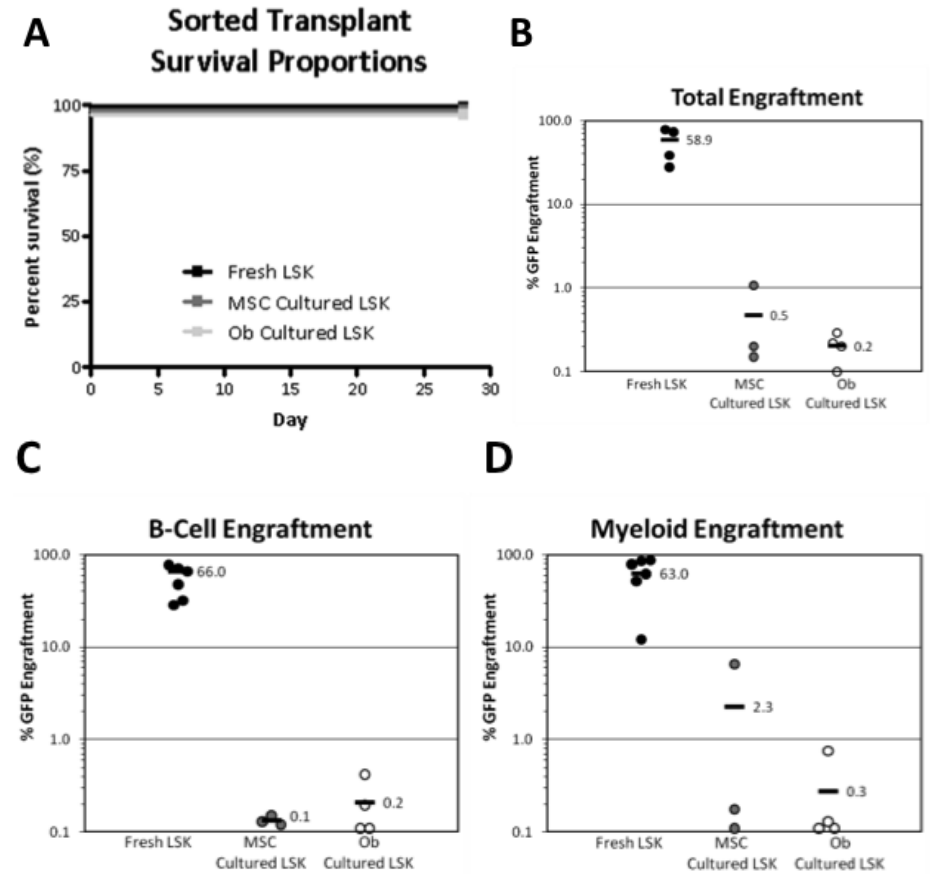
Figure 5. Primary transplantation of co-culture LSKs after removal of stromal cells. Co-cultures were initiated with GFP + LSKs and unlabelled MSCs or osteoblasts. After harvest of cultures, flow cytometry sorting was performed and only cells expressing GFP, containing cultured haematopoietic cells but devoid of undifferentiated MSCs or osteoblasts, were selected. These were then transplanted into myeloablated primary recipients. ( A ) Four week survival was 100% in each group. However, the proportion of GFP + LSKs contributing to total haematopoietic cells in the ( B ) blood, ( C ) B cells and ( D ) myeloid cells was significantly less compared to that demonstrated by fresh LSKs. ( n = 4 per group; data represent mean ±